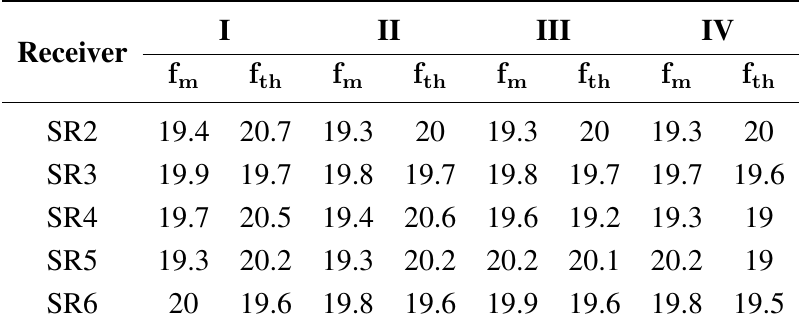
Table 2. Values of the measured f as a function of the arrangement of the SR array and position of the